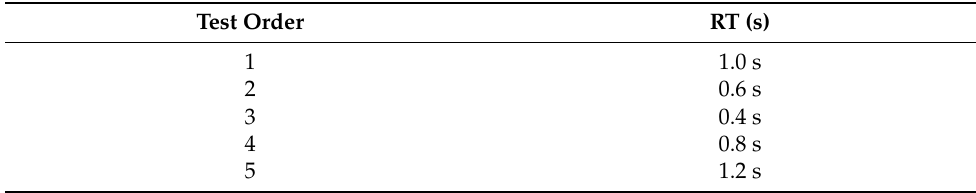
Table 8. Test order and reverberation time for speech intelligibility test.